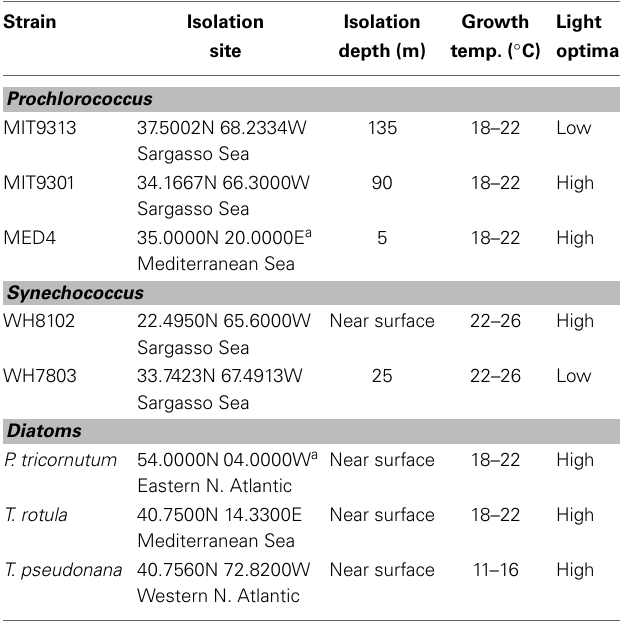
Table 5 | Isolation and niche information for the eight phytoplankton strains tested in this study.